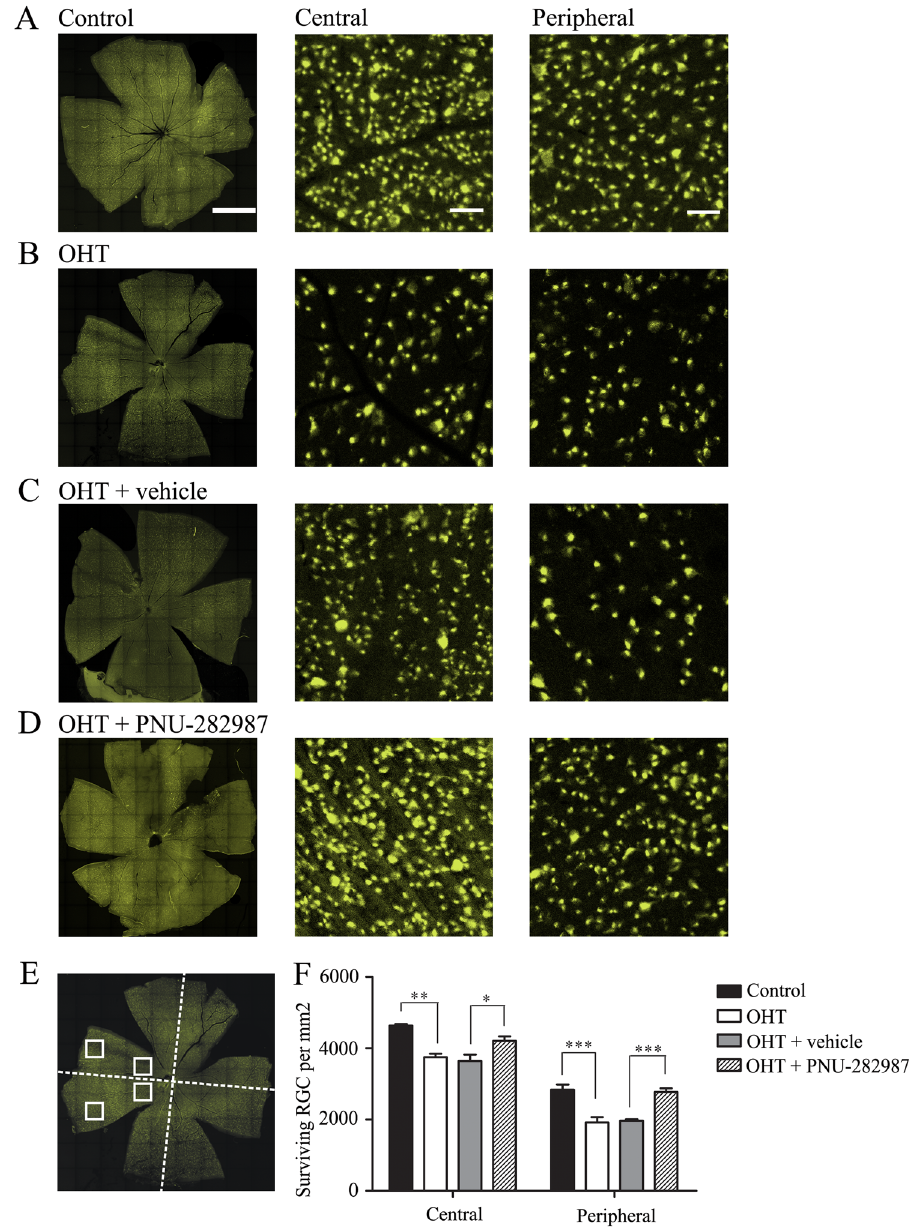
Figure 2. FluoroGold labeling of RGCs in normal and glaucomatous retinas. ( A–D ) FluoroGold labeling of surviving RGCs in flat-mounted retinas 3 weeks after inducing ocular hypertension. The left panels in A–D were photographed at low magnification (scale bar, 2 mm). Enlarged images (scale bar, 50 μ m) from the same retinas are shown in the central (middle) and peripheral (right) panels. PNU-282987 increased RGC viability and preserved cellular integrity ( D ) relative to the vehicle ( C ). ( E,F ) Quantitative analysis of RGC survival in control eyes, ocular hypertension eyes with or without the vehicle and PNU-282987-treated ocular hypertension eyes ( n = 10). * p < 0.05, ** p < 0.01, and *** p < 0.001 (one-way analysis of variance). The results are expressed as the mean ± SE. OHT, ocular hypertension; RGC, retinal ganglion